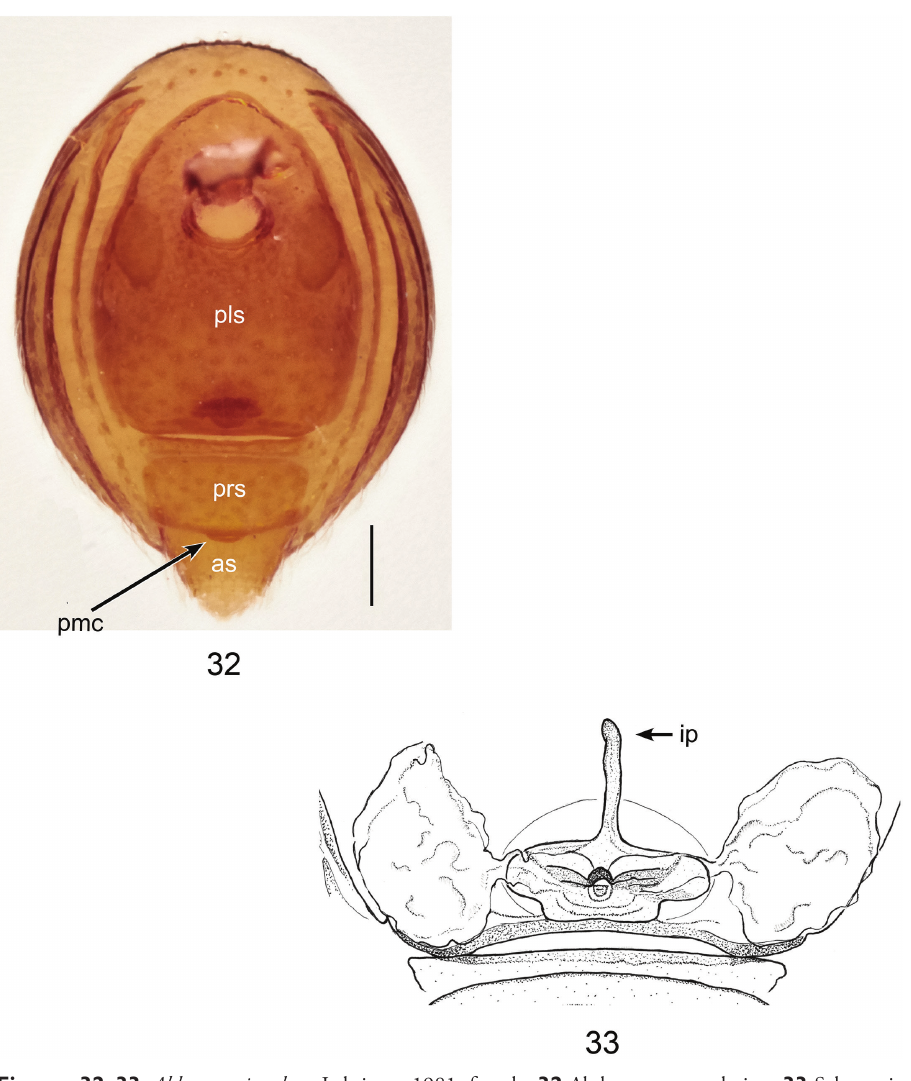
Carapace : Brownish orange; pars cephalica smooth dorsally, flat behind the ocu- lar area than sloping upward with a fringe of 5 pits of which each bear a seta, and 3 small tubercles at apical end, reticulated laterally; pars thoracica finely reticulated, sloping straight down and then at an angle (Figs 28, 31); clypeus brownish yel- low; sloping forward; short and smooth (Figs 30, 31). Sternum : Brownish orange; slightly wider than long, reticulated except medially (Fig. 29). Chelicerae : Yellow-